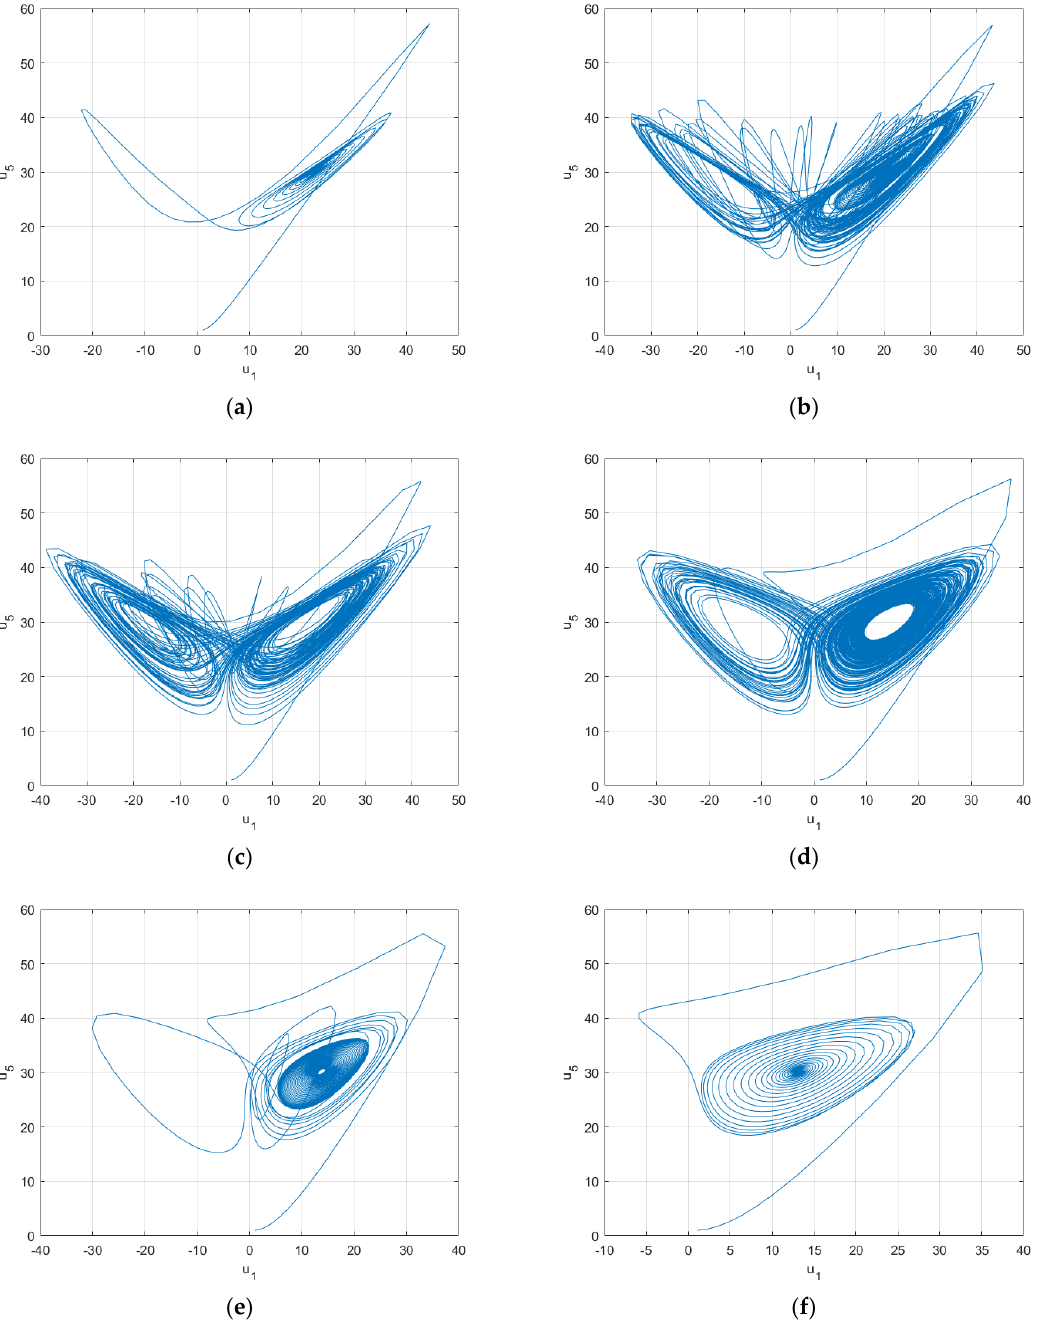
Figure 8. The evolution process of system (11) with parameter a . ( a ) a = 6, limit cycle; ( b ) a = 8, chaos; ( c ) a = 10, chaos; ( d ) a = 20, chaos; ( e ) a = 23, chaos; ( f ) a = 28, limit cycle.